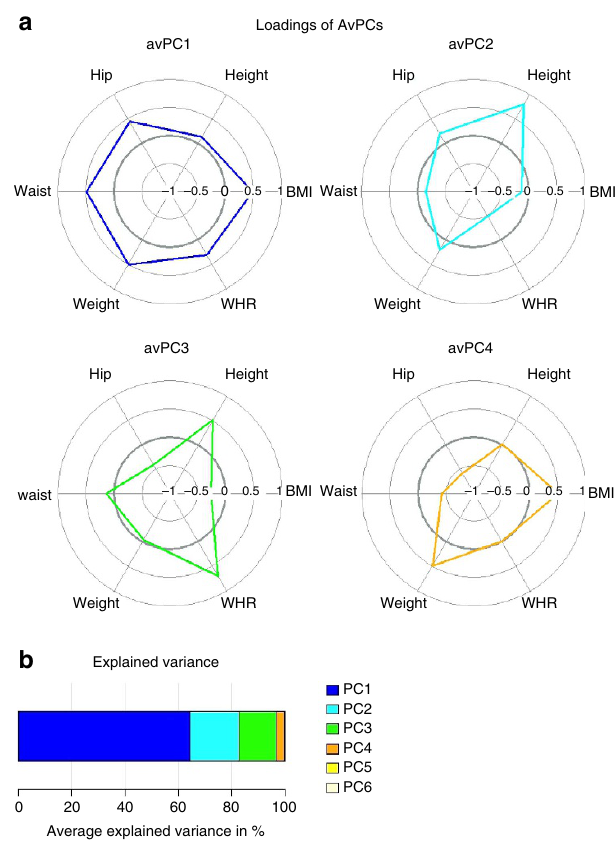
Figure 1 | Loadings and explained variance of AvPCs for body shape. ( a ) Loadings of AvPCs, and ( b ) explained variance of AvPCs for body shape. NATURE COMMUNICATIONS|7:13357|DOI: